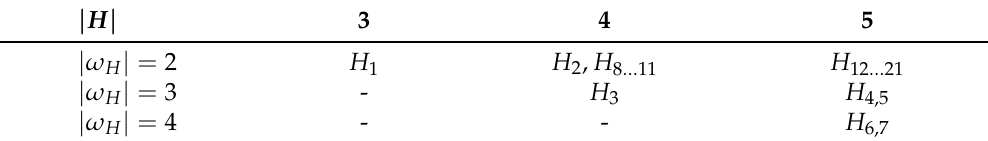
Table 1. The G -hypergroups with | H | ≤ 5.